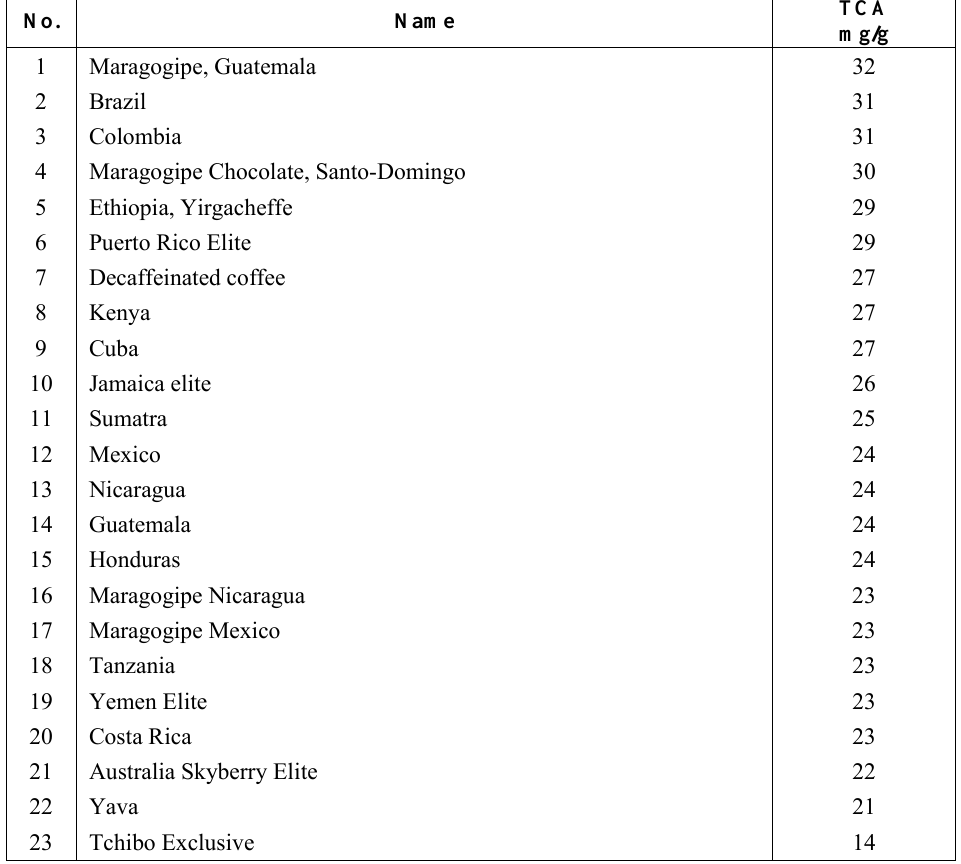
Table 9. Total Content of Antioxidants (TCA) in Coffee (Ground) (standard – quercetin). No. Name